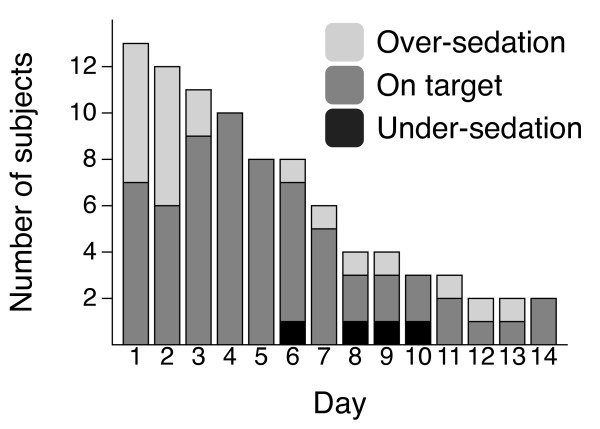
Success in reaching the target Richmond Agitation-Sedation Scale.